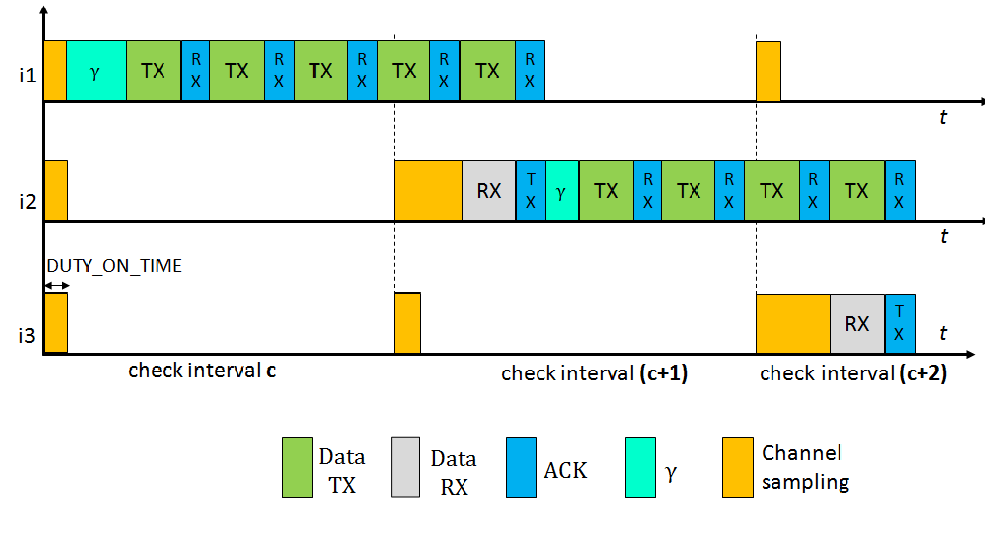
Figure 4. BoX-MAC behavior with communication